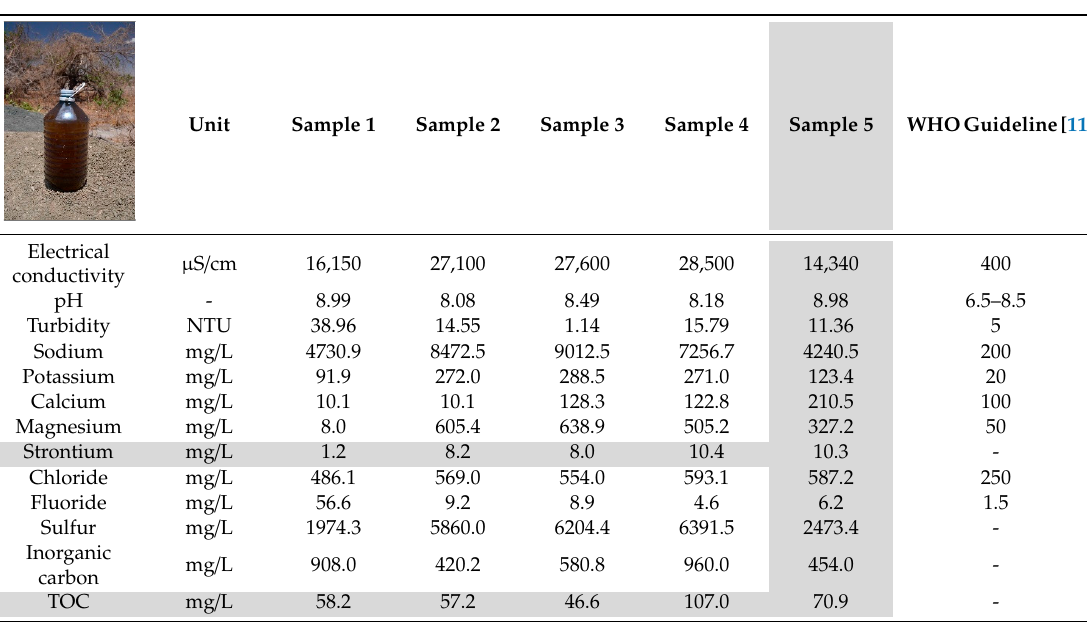
Figure 3. Left: photo of the open well for sampling (© Andrea Iris Schäfer); right: geographical location of groundwater sampling site (Burudika Lodge, Lake Manyara, Tanzania, map © OpenStreetMap contributors under the Open Database License). Table 4. Water quality of the groundwater samples in the Esilalei area (samples 1–4 were analyzed at Engler-Bunte Institute (EBI-KIT), and sample 5 was analyzed at the Beijing University of Chemical Technology (BUCT). Sample 5 was used as the feed solution in this study. Water quality variation occurs with location, season (in particular, rainfall) and probably extraction method/volume. The data in grew shadow indicate the quality parameters are most